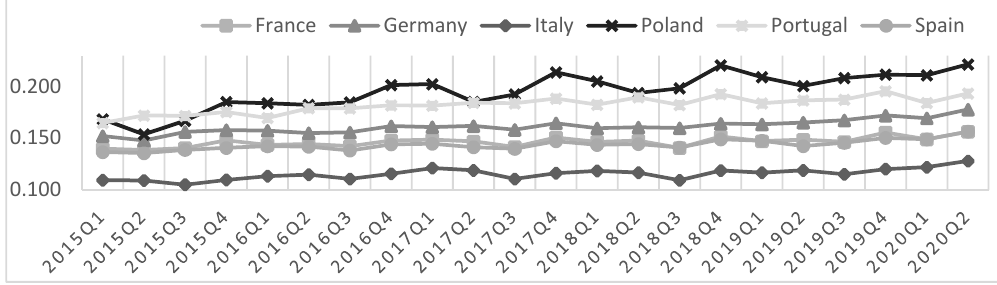
Figure 4. Import intensity coefficient of private consumption, own work, source: Eurostat.